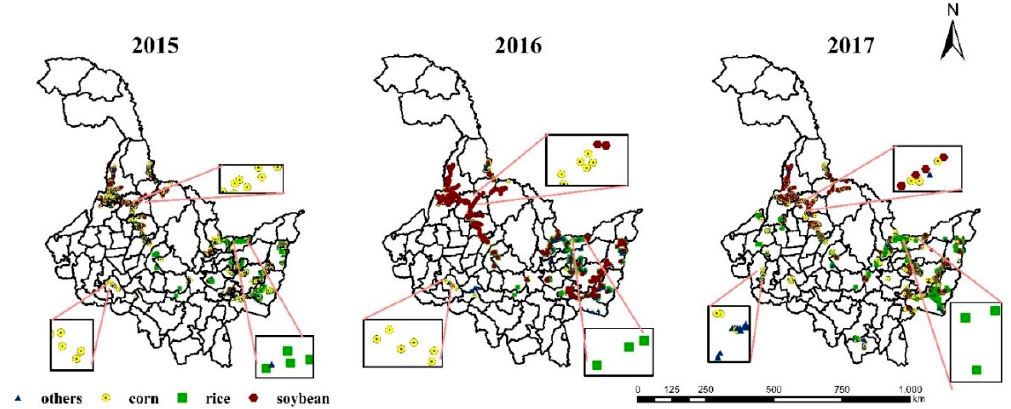
Figure 3. Heilongjiang three-year crop distribution map: yellow for corn, green for rice and red for soybean.